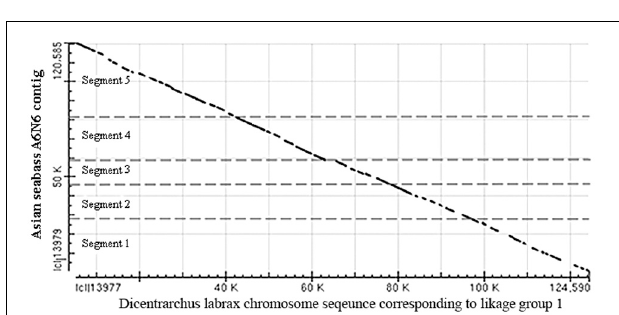
FIGURE 6 | Dot-matrix analysis of the arrangement of five contigs in the A6N6 scaffold showed good alignment with sequences corresponding to LG1 of European seabass. Vertical—18S rDNA scaffold, horizontal—European seabass ( Dicentrarchus labrax ) chromosome sequence corresponding to linkage group 1; (GenBank: FQ310506.3; 13,066,894–13,196,483bp). For the identity of the five contigs see Supplementary Table S2. These two species are distantly located on the phylogenetic tree of teleosts, but belong to the same order (see Figure 3B ).